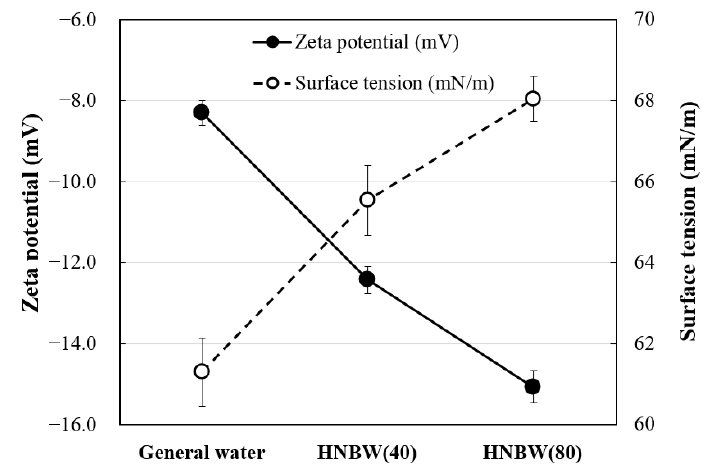
Figure 5. Zeta potential and surface tension according to the concentration of nanobubbles.